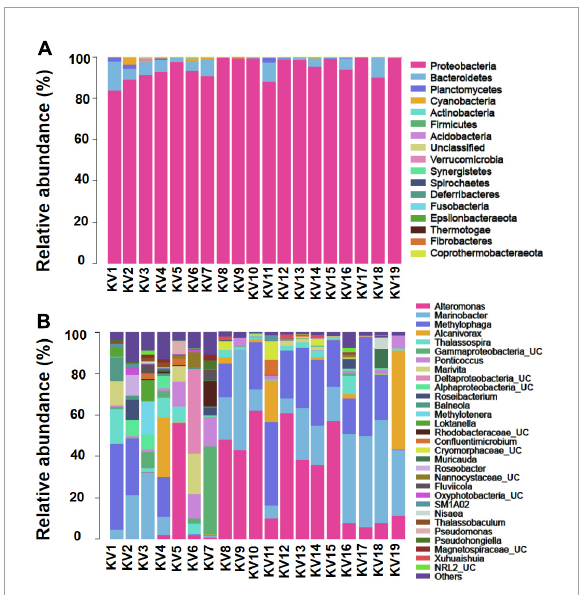
FIGURE1 Relative abundance of bacteria at phylum (A) and genus [top 30; (B) ] levels. The abundance is presented in terms of percentage in total effective features in a sample. UC,